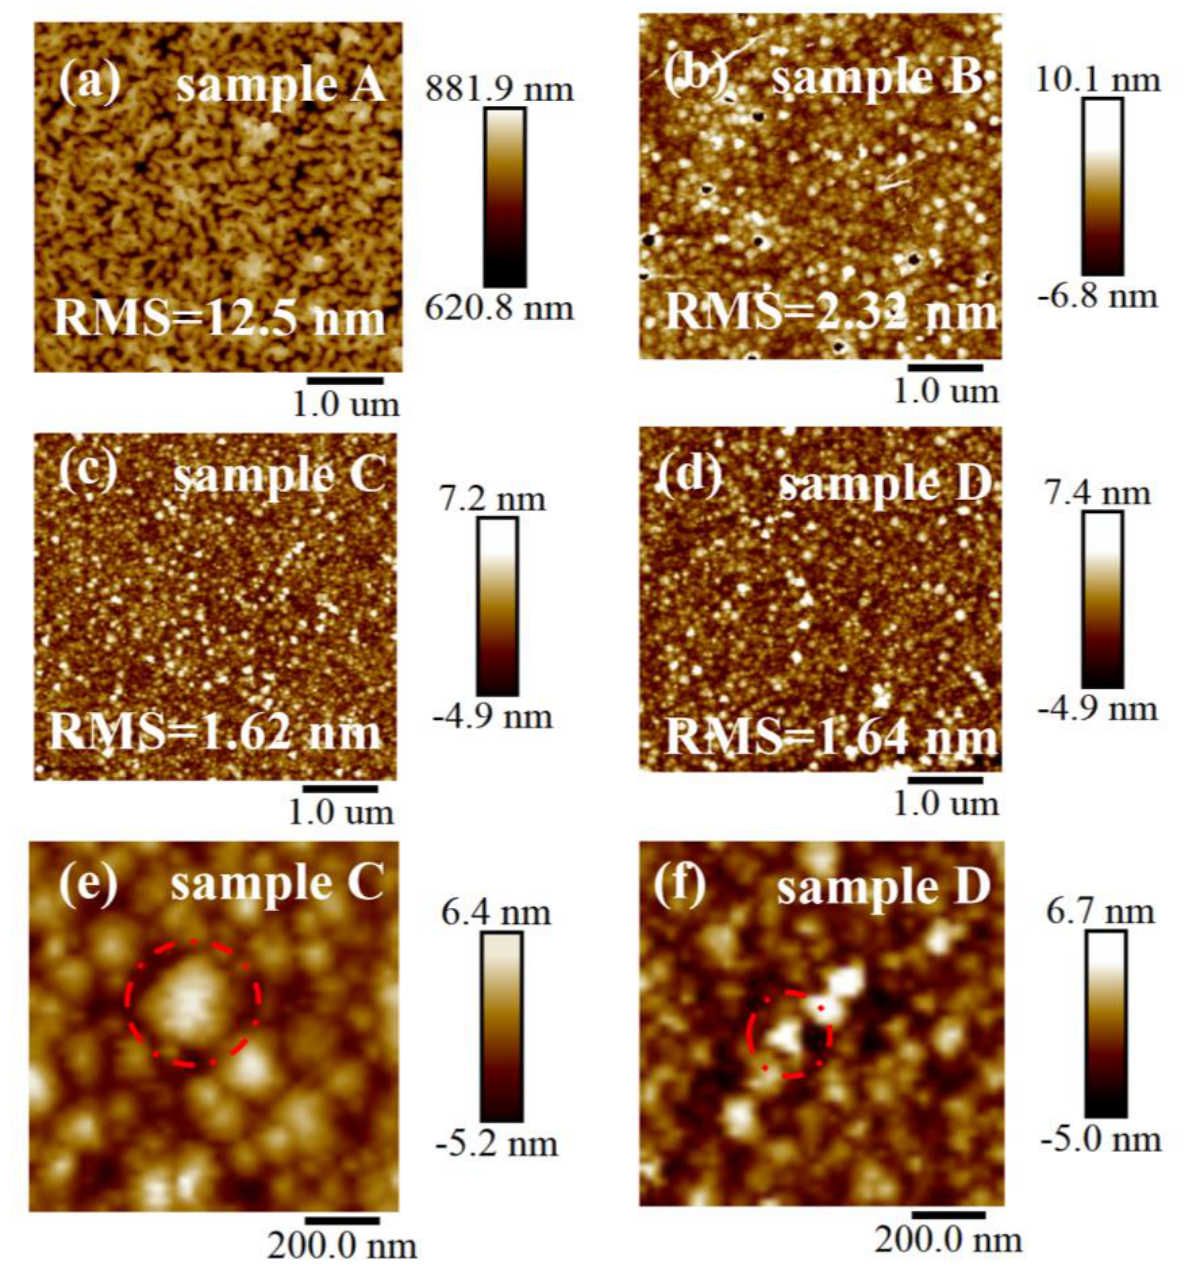
Figure 4. AFM images of the α -Ga 2 O 3 films grown at different temperatures: ( a ) 400 °C, ( b ) 420 °C, ( c ) 440 °C, ( d ) 460 °C. High-magnification AFM images: ( e ) sample C, ( f ) sample D.